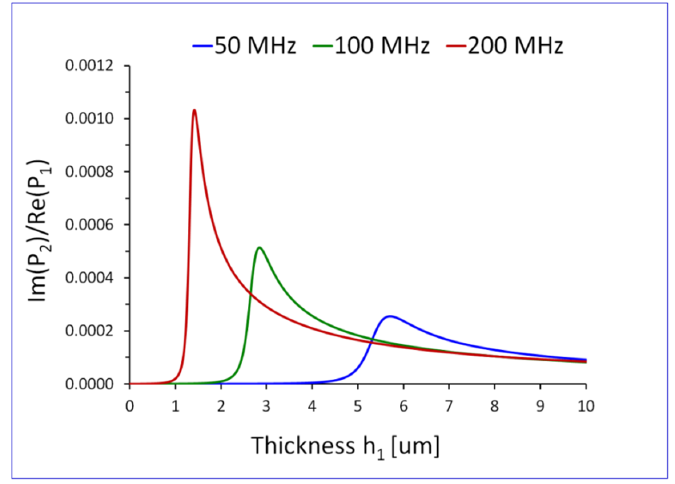
Figure 4. Reactive part ImP of the average power flow P , in the transverse direction x 2 , in the Newtonian liquid, normalized by the active average power flow Re ( P 1 ) in the direction of propagation x 1 , in the entire waveguide, shown in Figure 1. The plots are drawn as a function of thickness h 1 of the elastic surface layer, for different values of frequency f of the wave f = 50, 100 and 200 MHz. The waveguide is loaded with a Newtonian liquid of density ρ 0 = 1000 kg/m 3 and viscosity η 0 = 1 mPas.